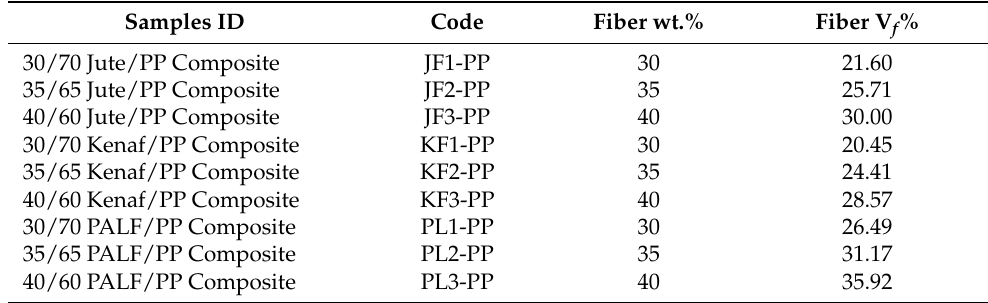
Table 3. Fiber weight, volume fractions, and layer configuration of the fiber-reinforced PP composites.